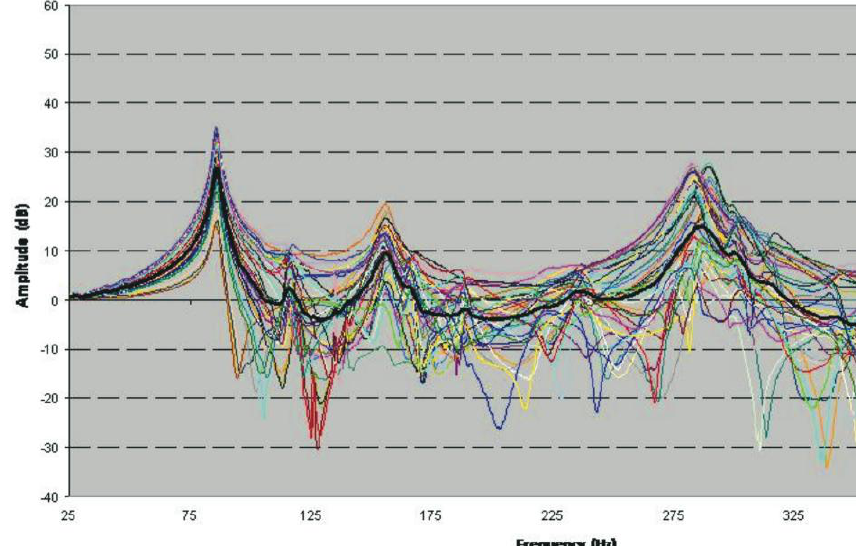
Figure 6. Transmissibility Naked Metal Sheet plus Lightweight Multilayer